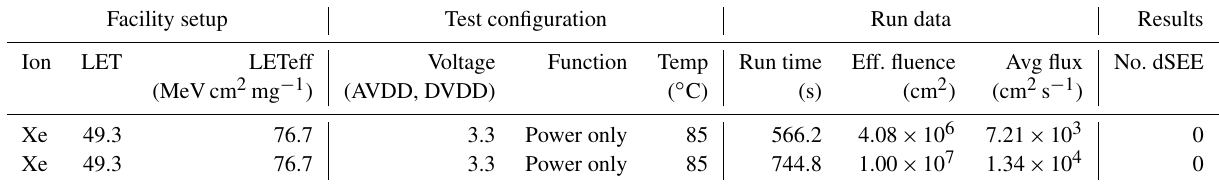
Table 3. Data test run log. LETeff is effective linear energy transfer and No. dSEE is number of detected single-event